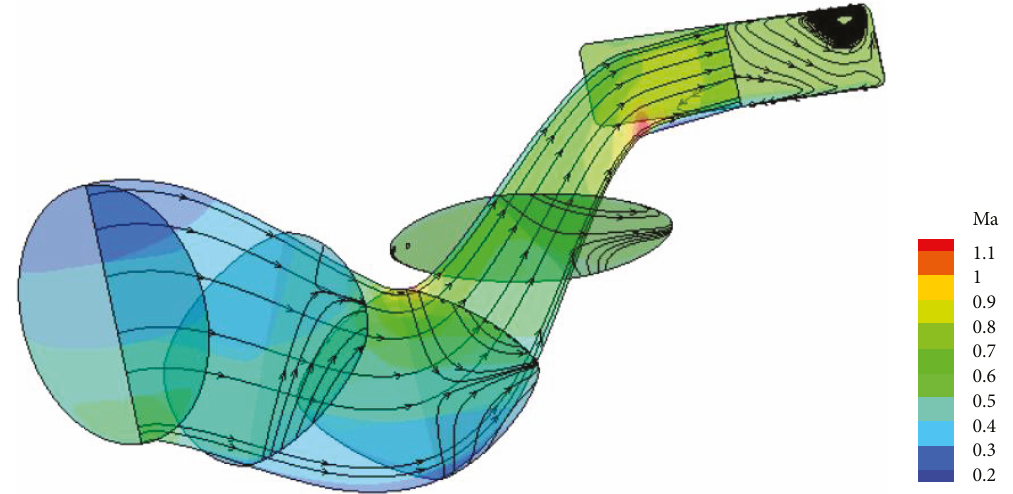
Figure 12: Streamlines of cross-sectional planes (colour denotes Mach number).